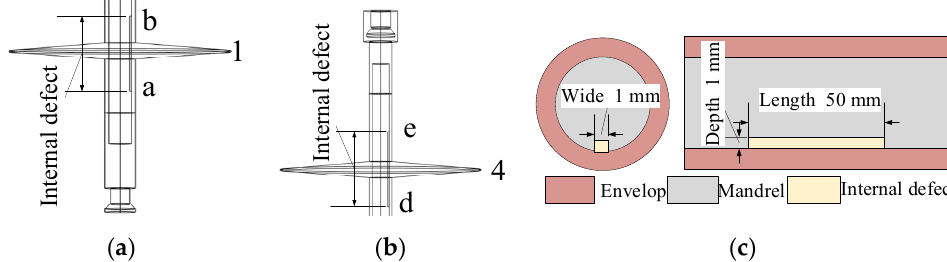
Figure 5. Calculation model of the composite insulators with internal defects: ( a ) between “ a ”–“ b ”; ( b ) between “ d ”–“ e ”; ( c ) the internal defect model. Table 3. Calculation results of the electric field on the surface of the damaged composite insulator.